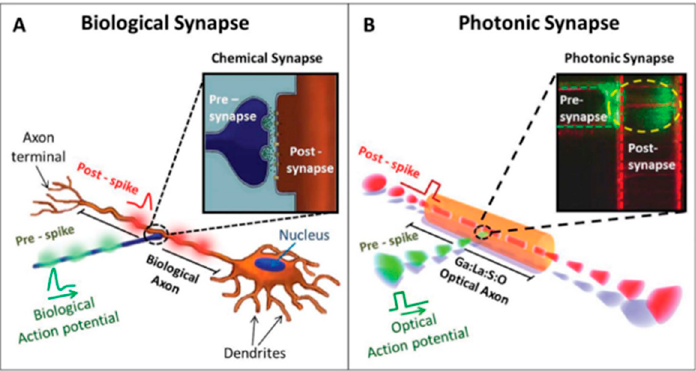
Figure 3. Comparison of photons with biological neurons and synapses [80]. ( A , B ) is biological synapse and photonic synapse , respectively.